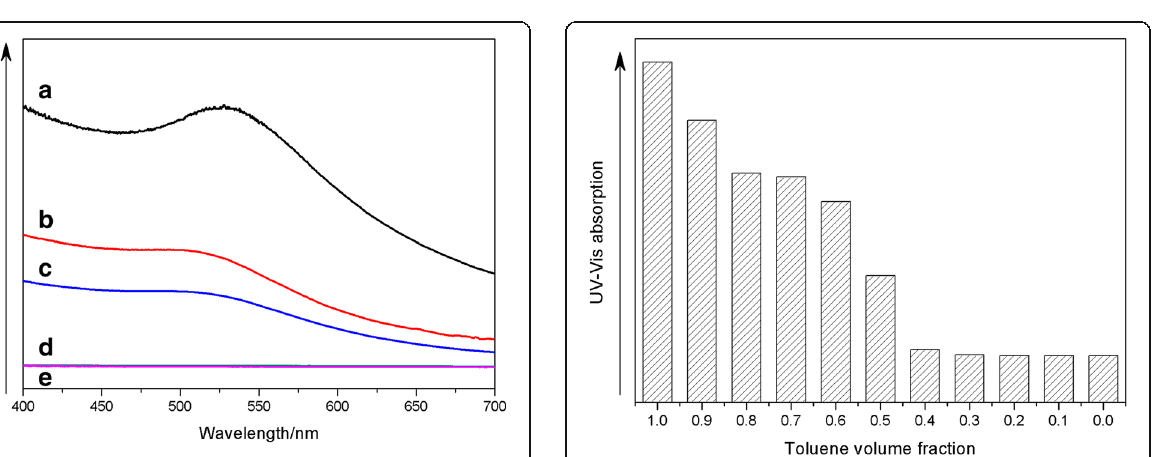
Fig. 6 UV-Vis absorption curves for saturated solutions of Au@DSHPG-2.